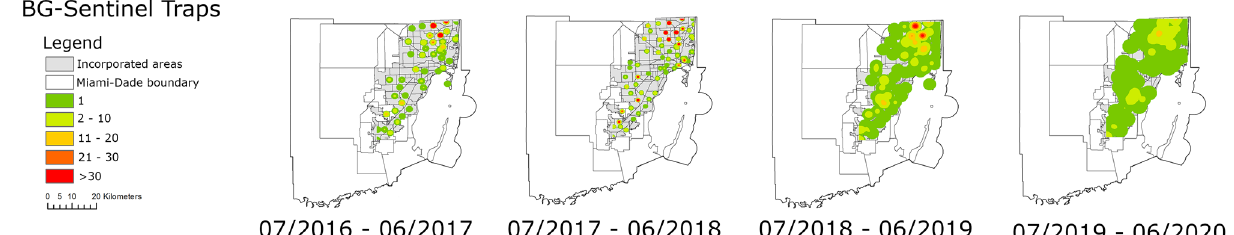
Figure 2. Heat map based on the relative abundance of species from the Culex coronator complex collected by the BG-Sentinel traps in Miami-Dade County, Florida from July 2016 to June 2020. The color gradient represents the sum of species from the Cx. coronator complex collected by each BG-Sentinel trap in a 12 months period. The figure was produced using ArcGIS 10.2 (Esri, Redlands, CA), using freely available layers from the